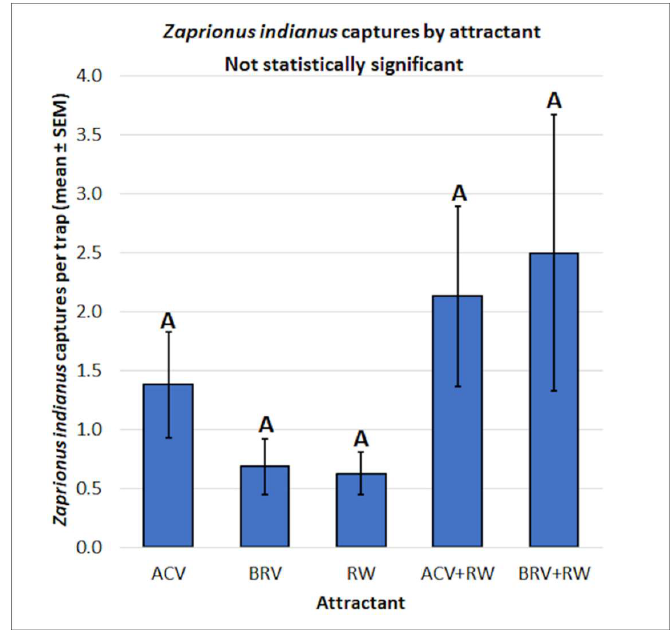
Figure 7. Mean (± SEM) Zaprionus indianus captures by attractant type. Different letters represent statistically significant differences ( p < 0.05, Tukey’s HSD test) between attractant solutions. There were no significant differences observed in the mean captures of Z. indianus by week (f = 2.74, df = 3, 60, p = 0.0511); the interaction between attractant and week was also non-significant (f = 1.81, df = 12, 60, p = 0.0671) (Figure 8).